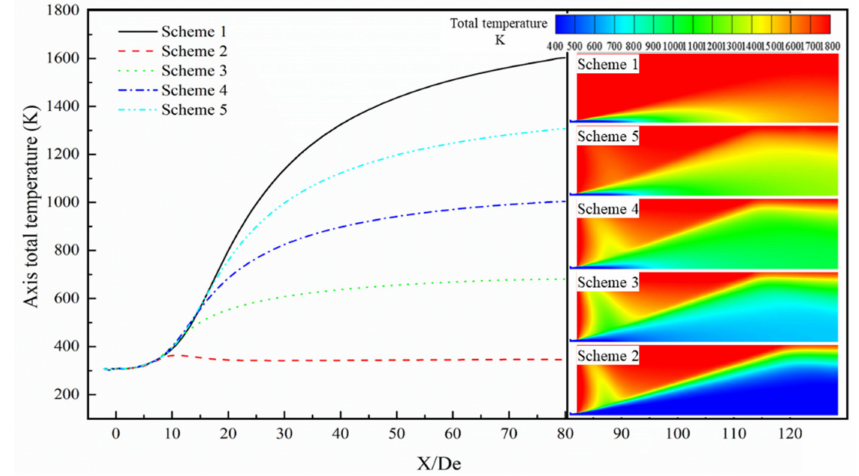
Figure 11. Axis total temperature distribution of the supersonic jet produced by the Laval